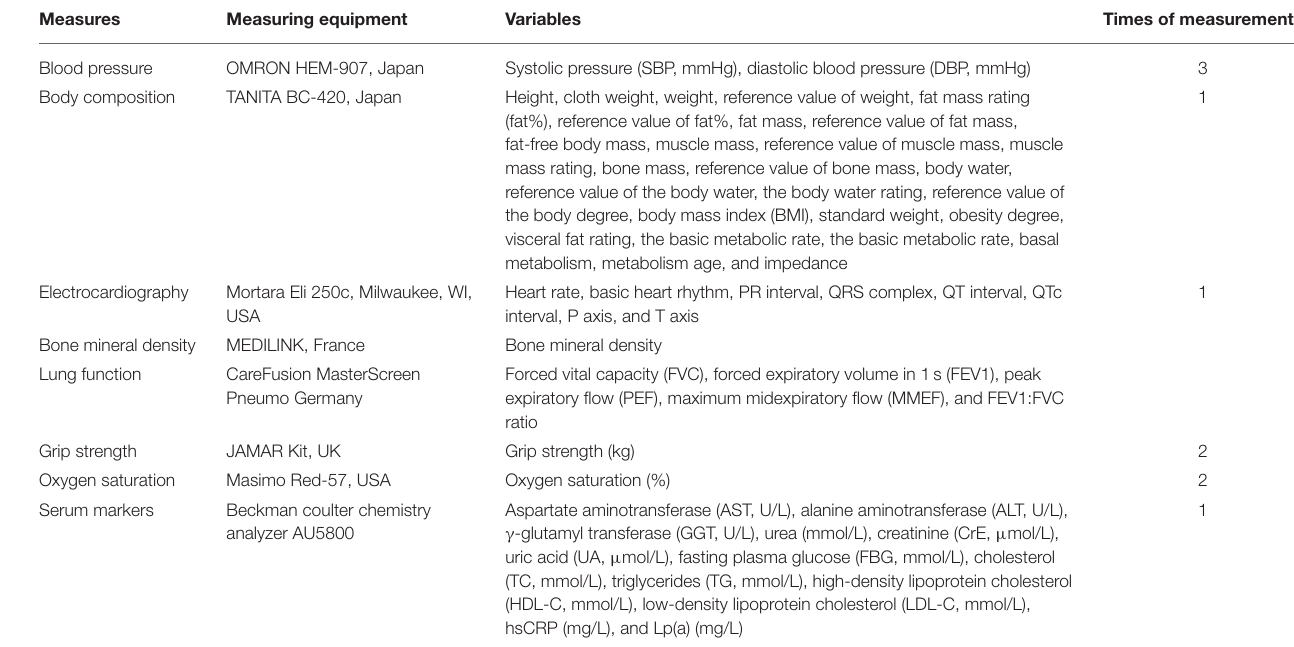
TABLE 3 | Physical examination measurements and laboratory